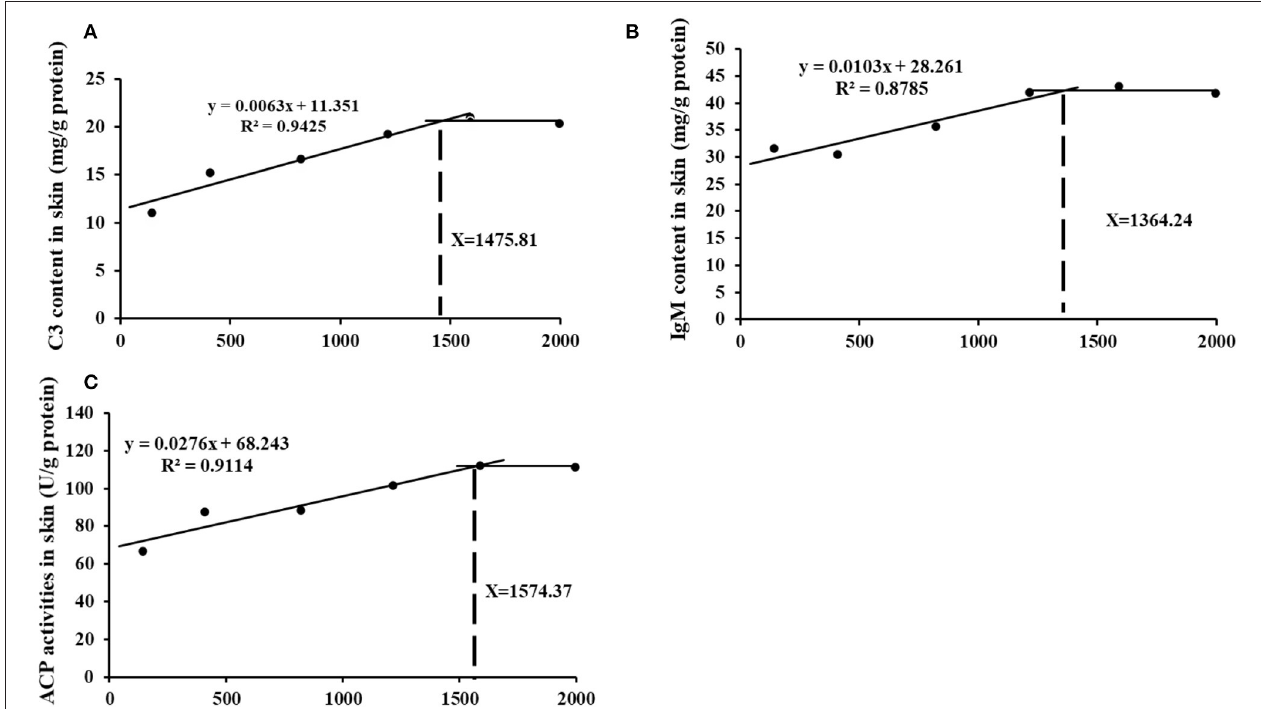
FIGURE 7 | Broken-line analysis of C3 (A) , IgM (B) , and ACP content (C) in skin for grass carp ( Ctenopharyngodon idella ) fed diets containing graded levels of choline after infection with A. hydrophila .